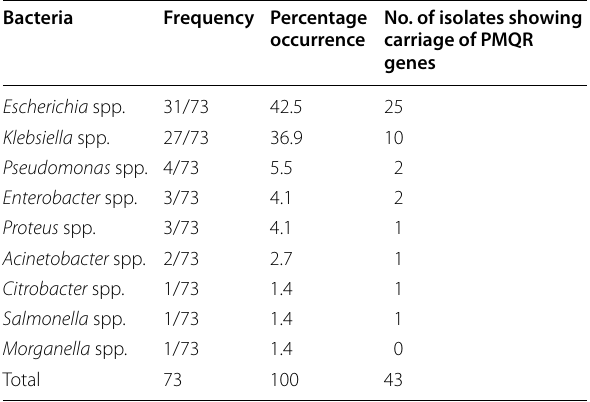
genera and their carriage of PMQR genes